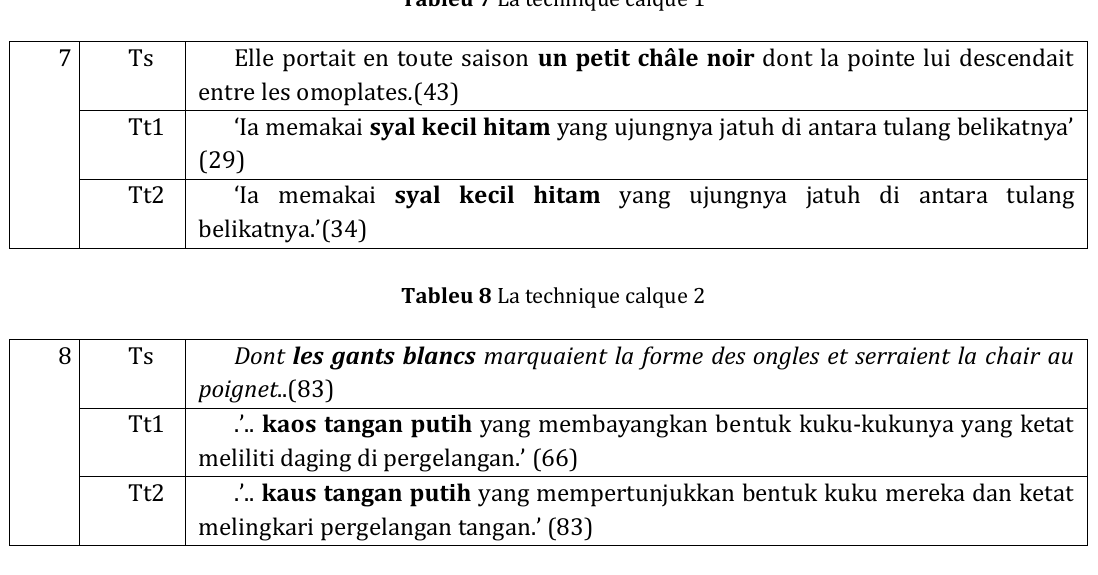
Tableu 7 La technique calque 1